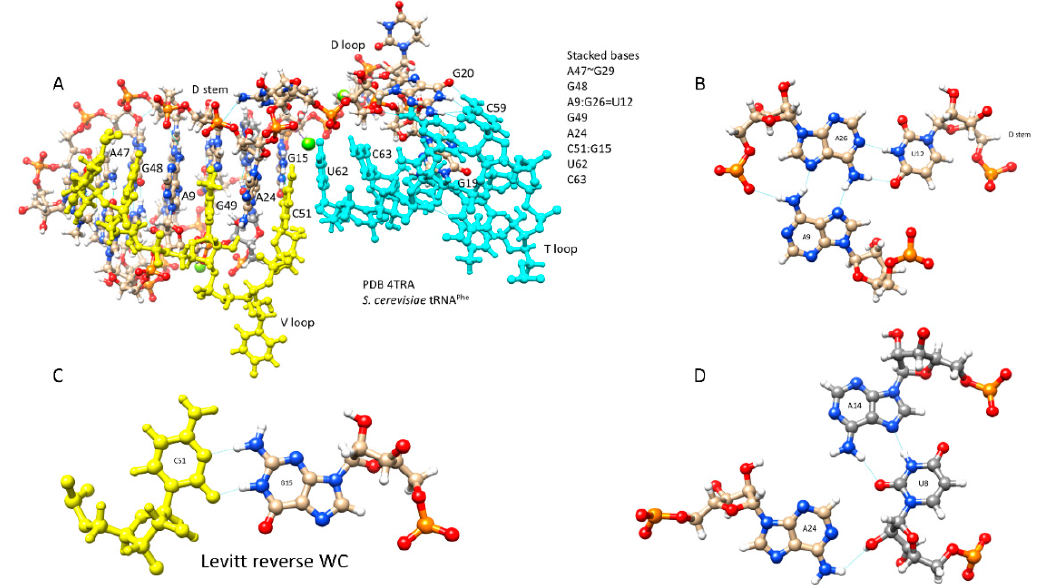
Figure 3. D loop-V loop-T loop interactions (the tRNA “elbow”). ( A ) Stacked bases. ( B ) Interaction of A9-U12-A26. ( C ) The Levitt base pair (G15:C51). ( D ) Interaction of U8-A14-A24. Blue lines indicate hydrogen bonds. The image is from PDB 4TRA [9] .